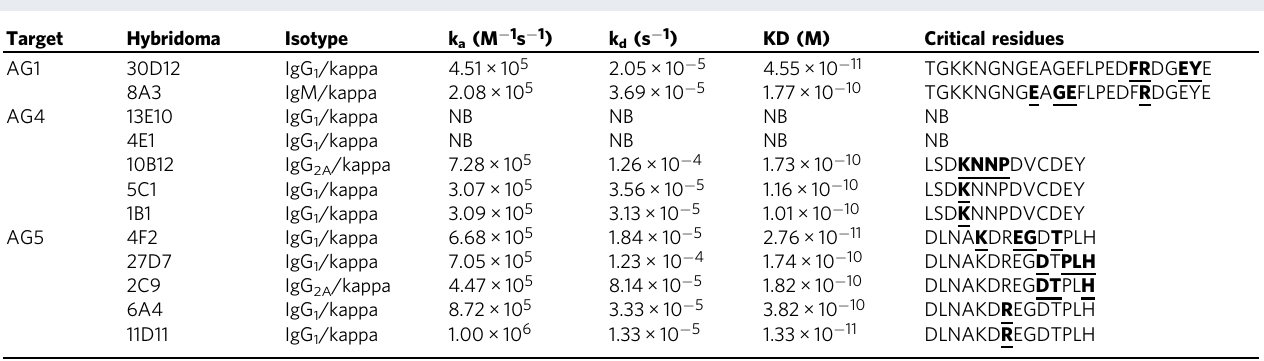
Table 1 mAb characterization by isotyping, SPR and alanine scan